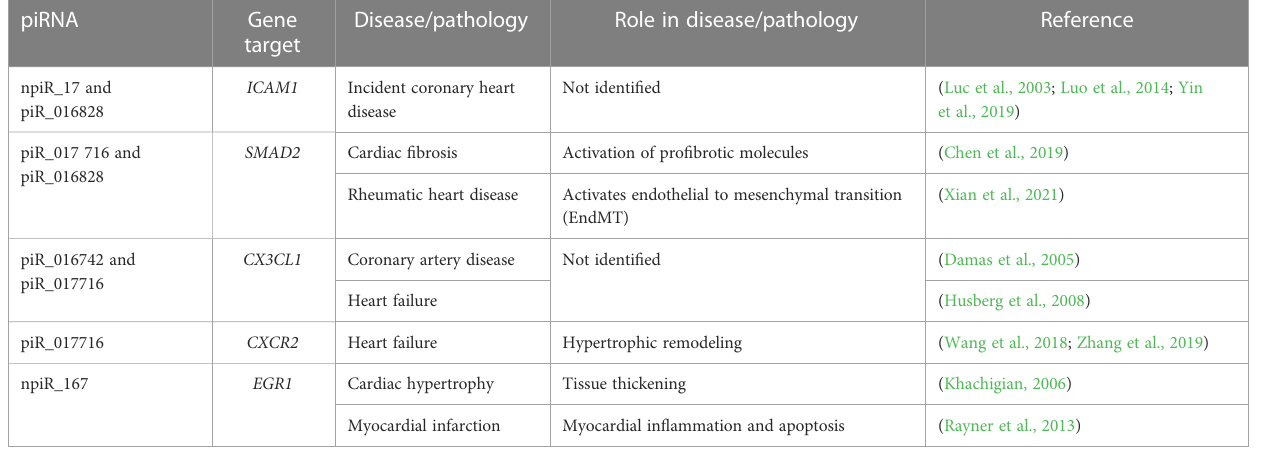
TABLE 1 Dysregulated piRNAs and their predicted targets linked to various cardiovascular pathologies.